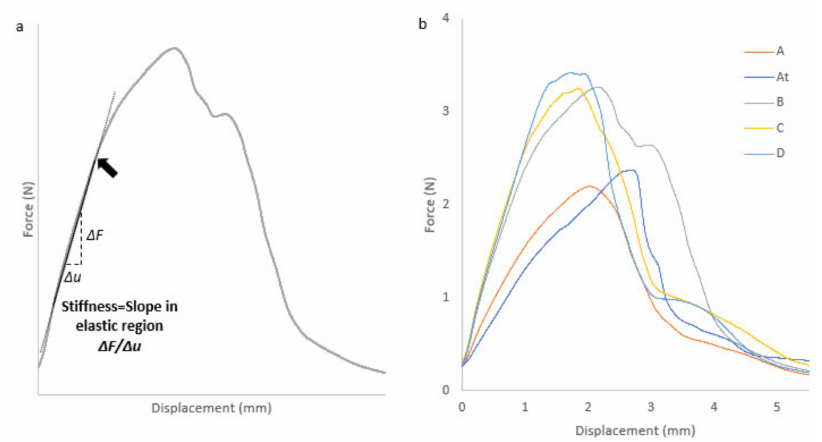
Figure 10. Stress–strain curve of filament sample in tensile tests. An arrow indicates the elastic limit ( a ). Stress-Strain curve of filaments corresponding to formulation A [41], A T , B, C, D ( b ).